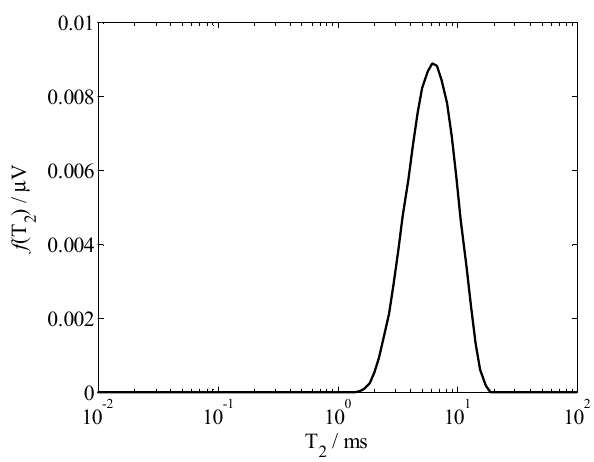
Figure 10. T 2 spectrum curves of sample A (moisture content is 8.53%).